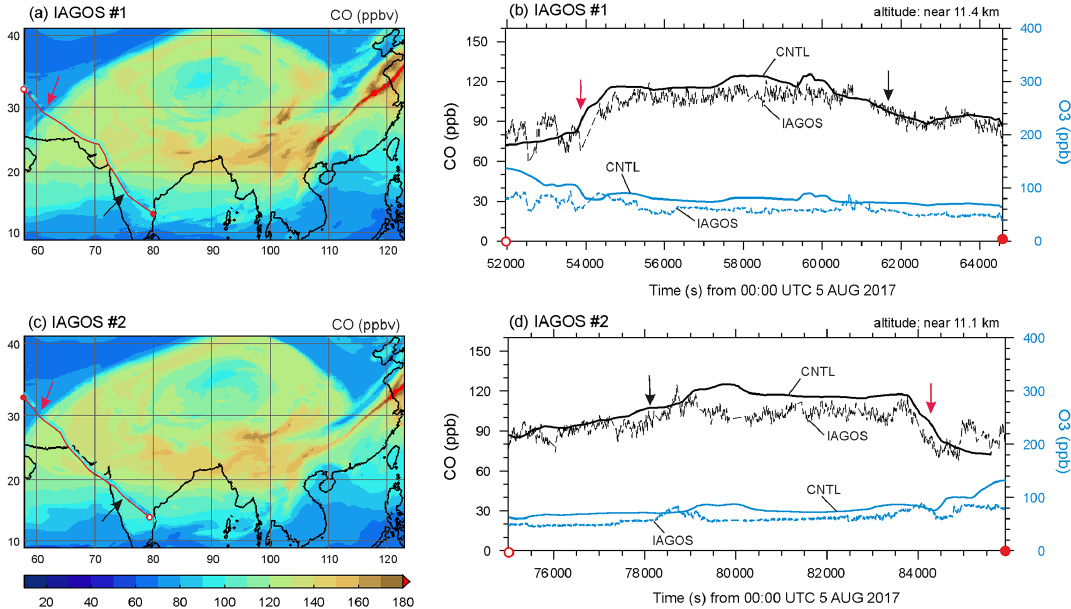
Figure 6. IAGOS-measured (dashed lines) and Meso-NH-derived (solid lines) CO concentration (black lines) and O 3 concentration (blue lines) along the IAGOS flight tracks on 5 August 2017. In (a) and (c) , Meso-NH-derived CO concentration at the altitude of 11.1km are displayed by shaded areas, while the IAGOS-measured CO concentration every 5min are displayed by coloured circles along the track (red lines). In (b) and (d) , IAGOS-measured CO and O 3 concentrations every 4s are displayed. In (a–d) , the starting (ending) point of each flight within the domain is marked by open (closed) red circles, while the location of the steep (gradual) change of CO concentration is marked by red (black) arrows. Table 3. List of sensitivity experiments and the duration and area of emission modifications. For the area of modification, see Fig. 2. Exp. SIC06 SIC01 CHN01 IND01